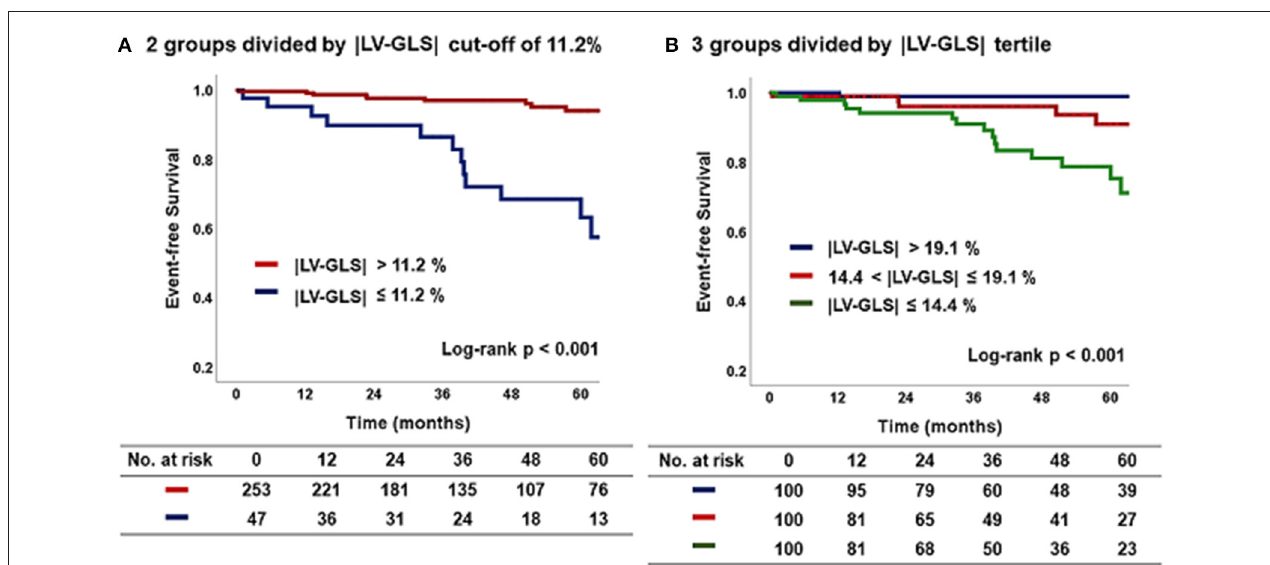
FIGURE 4 | Kaplan–Meier curve according to |LV-GLS| on post-PM echocardiogram. (A) The group of |LV-GLS| ≤ 11.2% revealed a significantly worse CV outcome than the other group (log-rank p < 0.001). (B) The lowest |LV-GLS| group revealed a significantly worse CV outcome than the others (log-rank p < 0.001). |LV-GLS|, absolute value of left ventricular global longitudinal strain; PM, pacemaker; CV,